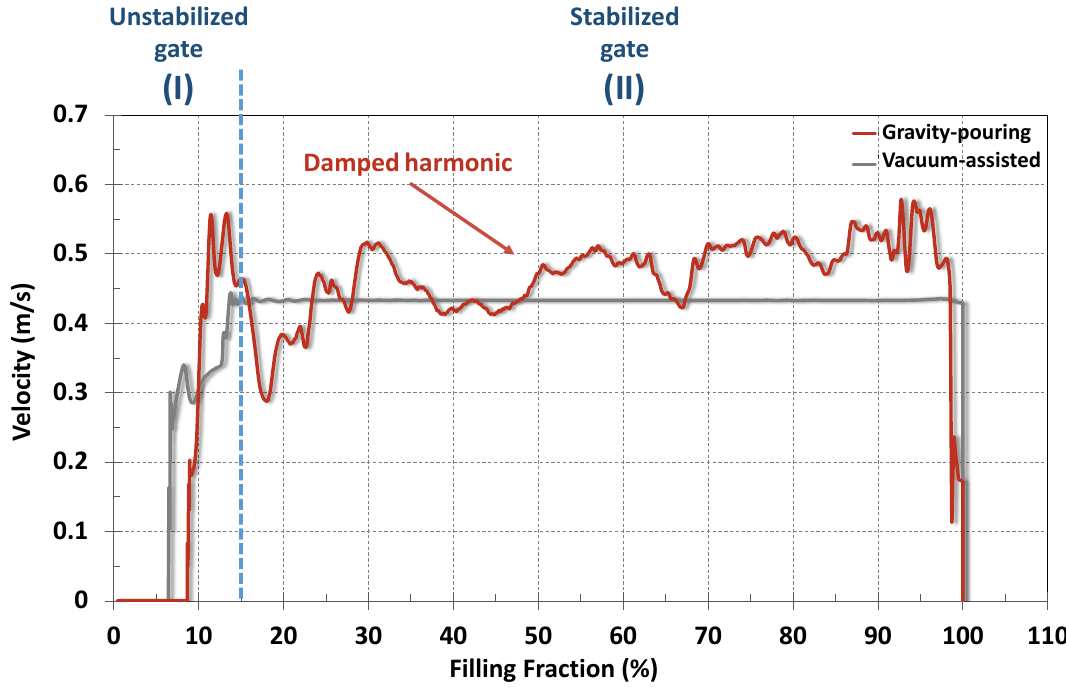
Figure 8. Velocity profile on the gates of both moulds during the filling process.